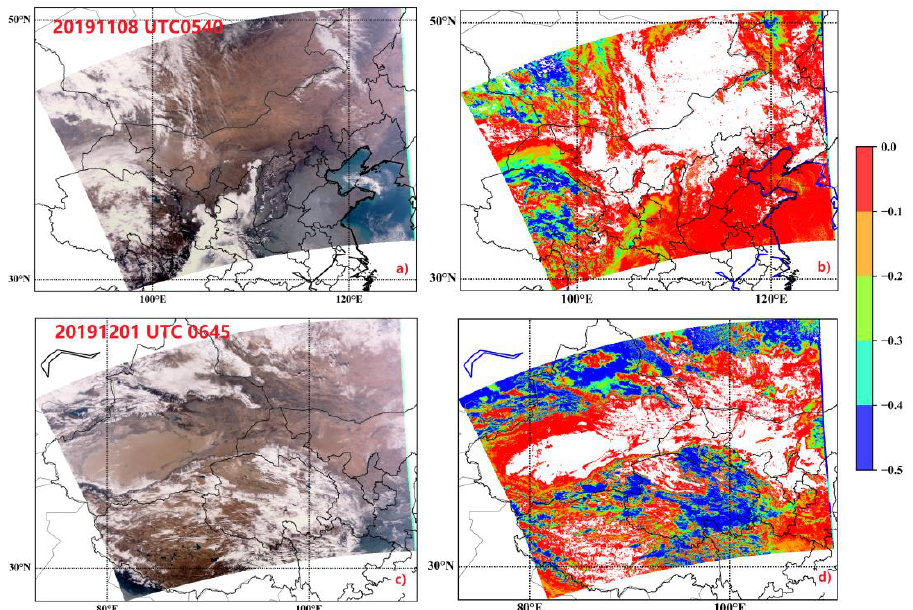
Figure 5. True color map and the distribution of the difference between R 0.865 and R 1.64 . ( a ) True color map at UTC0540 on 8 November 2019; ( b ) the difference between R 0.865 and R 1.64 at UTC0540 on 8 November 2019; ( c ) True color map at UTC0645 on 1 December 2019; ( d ) the difference between R 0.865 and R 1.64 at UTC0645 on 1 December 2019.